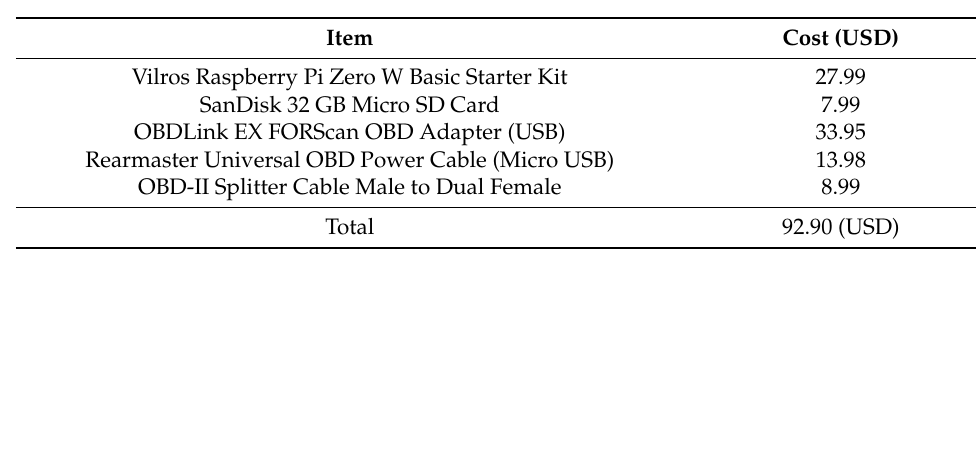
Figure 5. Raspberry Pi Zero W installed under the driver’s side dashboard in the Hyundai Ioniq Battery Electric to request and receive OBD-II data from the vehicle. Table 2. List of hardware used and costs for OBD-II logging